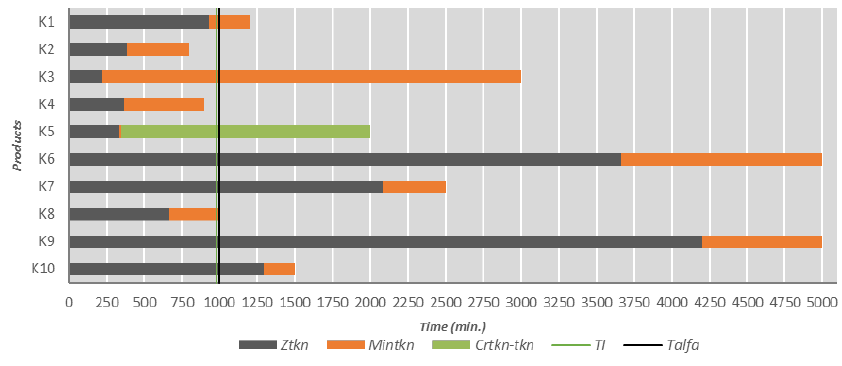
Figure 4. The chart of the first iteration for the product family.